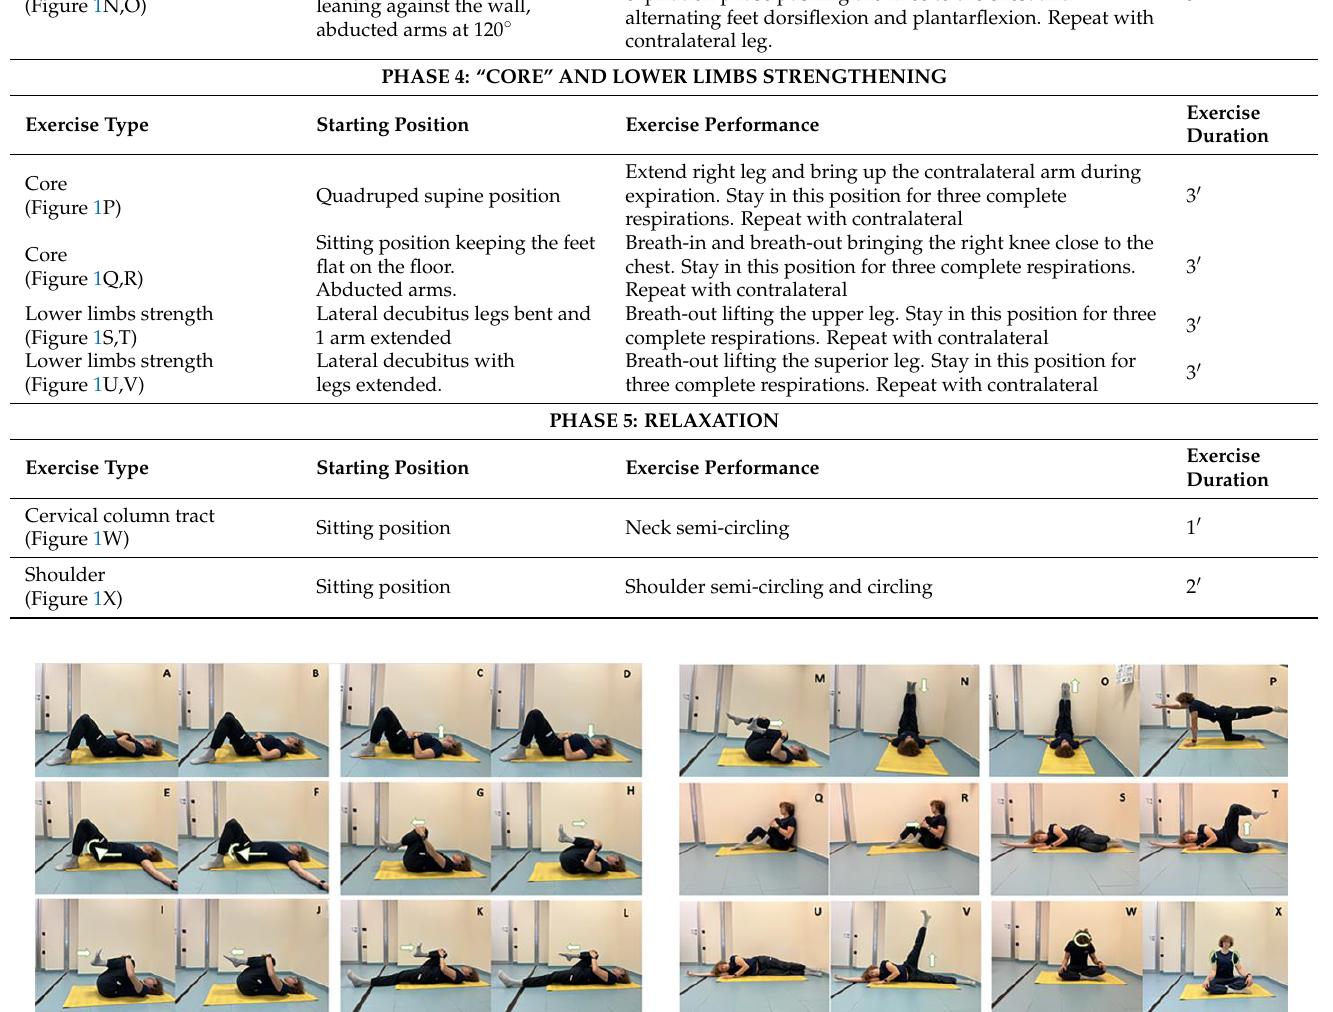
Figure 1. Example of active stretching exercise protocol (the letters( A – X ) are referred to each exercise reported in Table